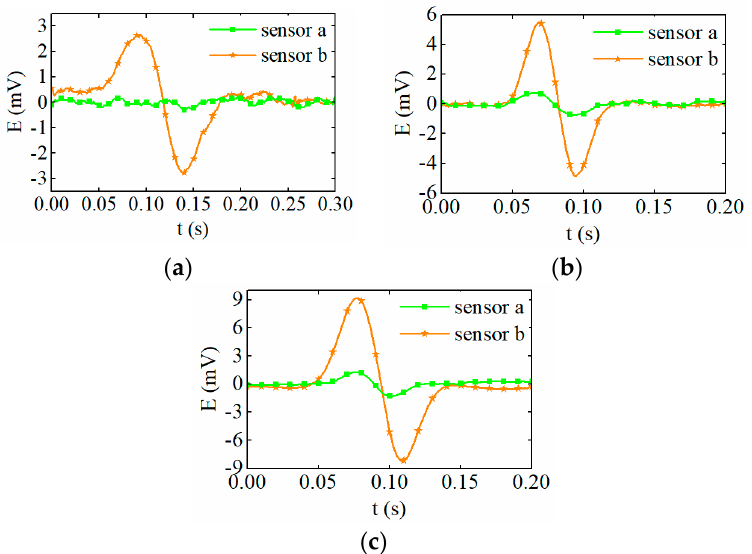
Figure 12. The particle signal output by the sensors. ( a ) 75 μ m, ( b ) 120 μ m, ( c ) 150 μ m.